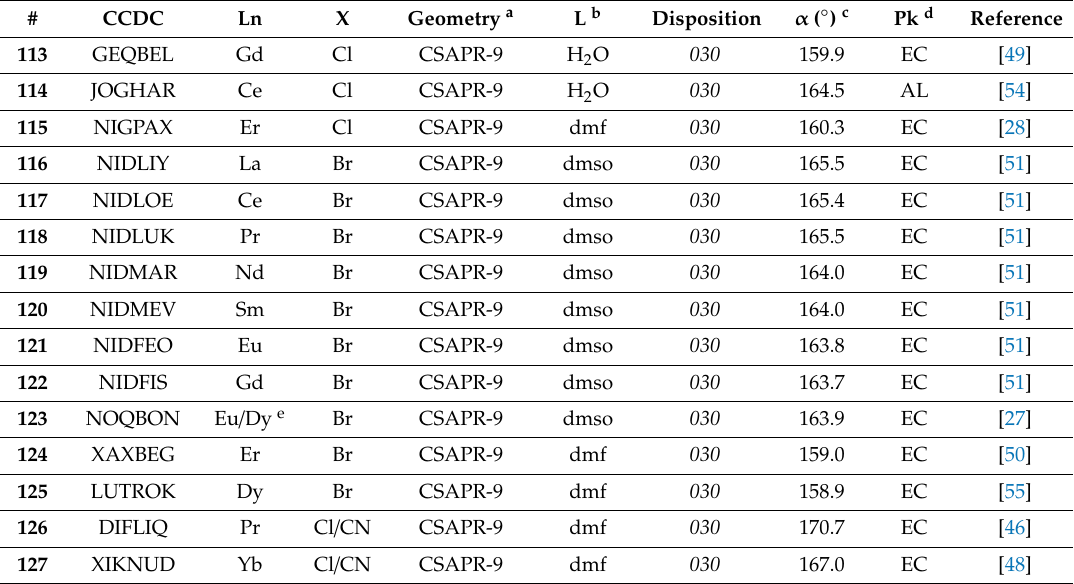
Table 5. Reported Ln-anilato compounds with a rectangular 2D structure and a herringbone